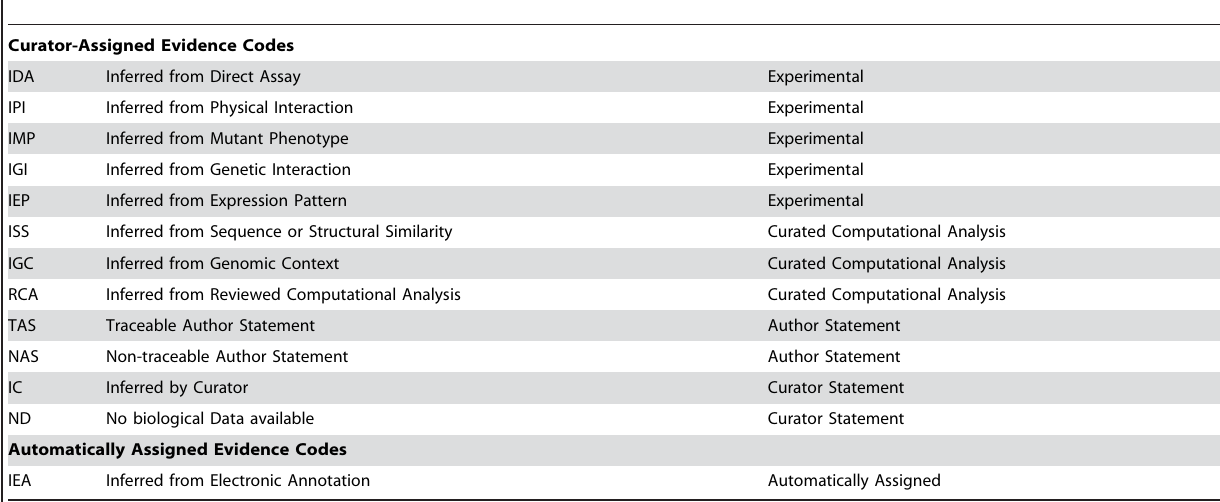
The table lists evidence codes as defined by the Gene Ontology Consortium (http://www.geneontology.org/GO.evidence.shtml). It shows the evidence codes, corresponding phrases, and broader categories describing how the evidence codes are associated with gene products.